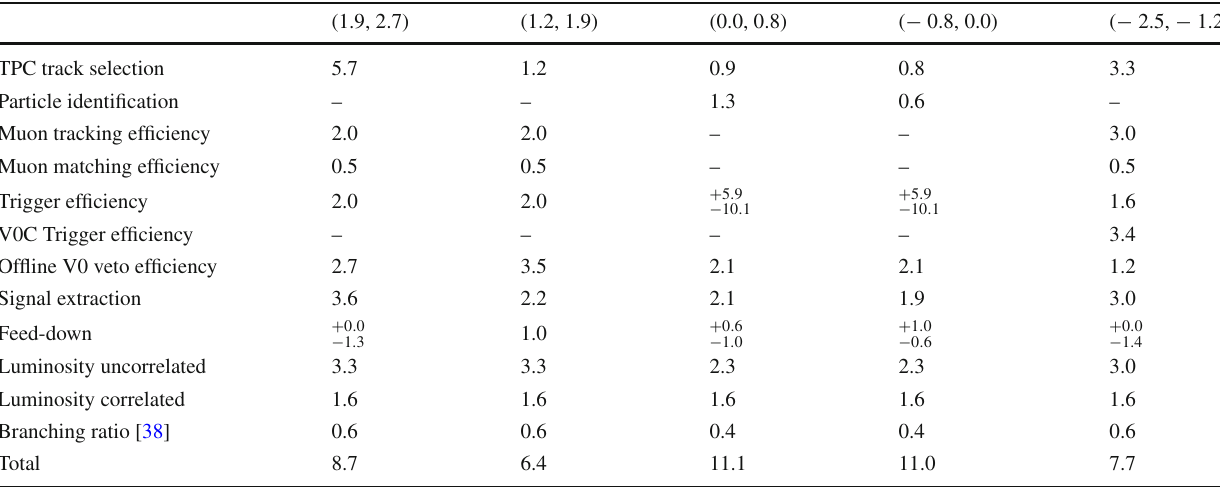
Table 2 Summary of the contributions to the systematic uncertainty, in percent, for the J /ψ cross section in the different rapidity